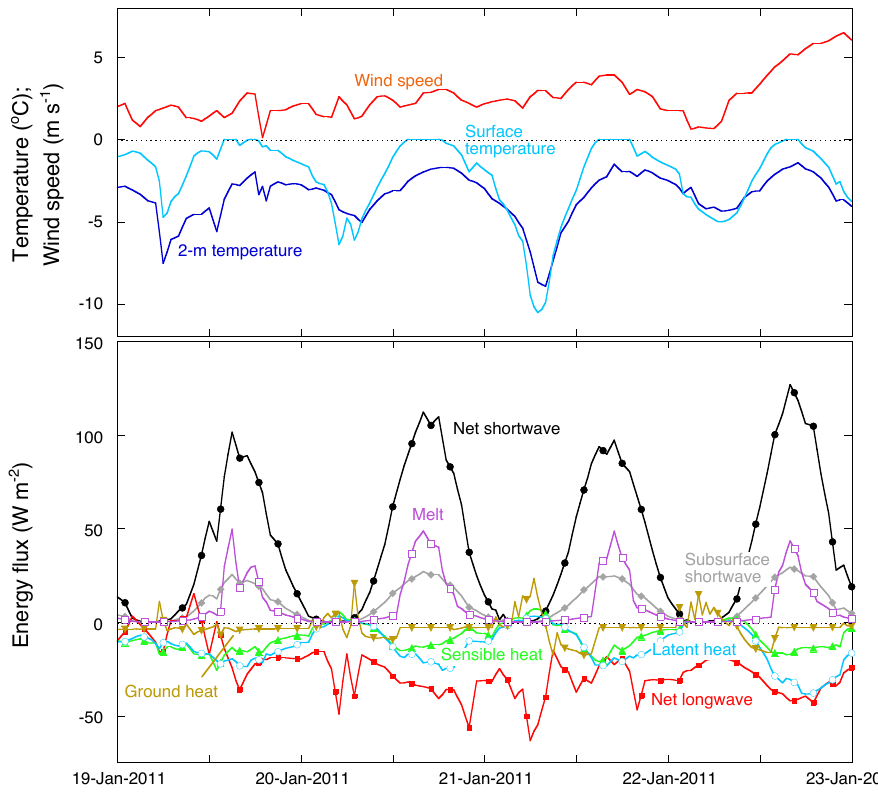
Fig. 10. Meteorological conditions (upper panel) and selected SEB components (lower panel) during a four-day period showing typical daytime